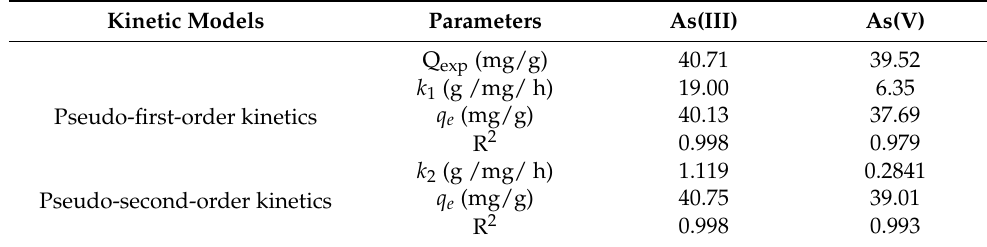
Table 1. Fitted parameters of the pseudo-first-order and pseudo-second-order models for As(III) and As(V) adsorption by S-nZVI.